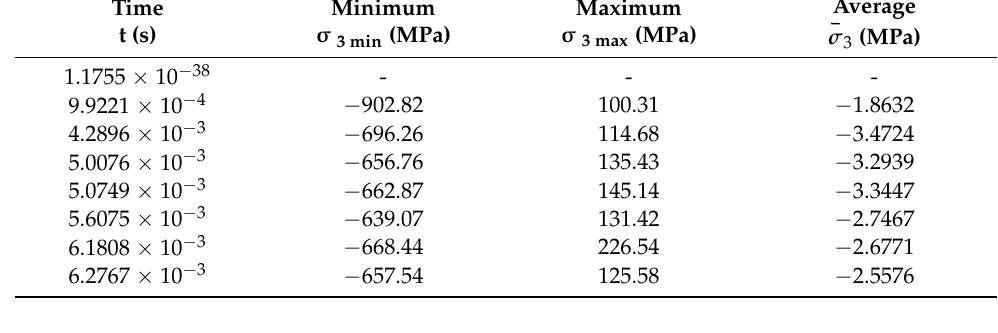
Figure 10. Computed ANSYS equivalent elastic strain map: ( a ) for the gear; ( b ) global view of the assembly.